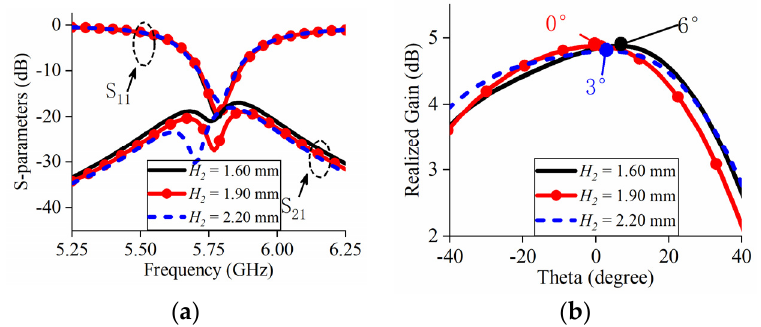
Figure 3. Effect of H 2 on antenna performance: ( a ) S-parameters and ( b ) radiation patterns.